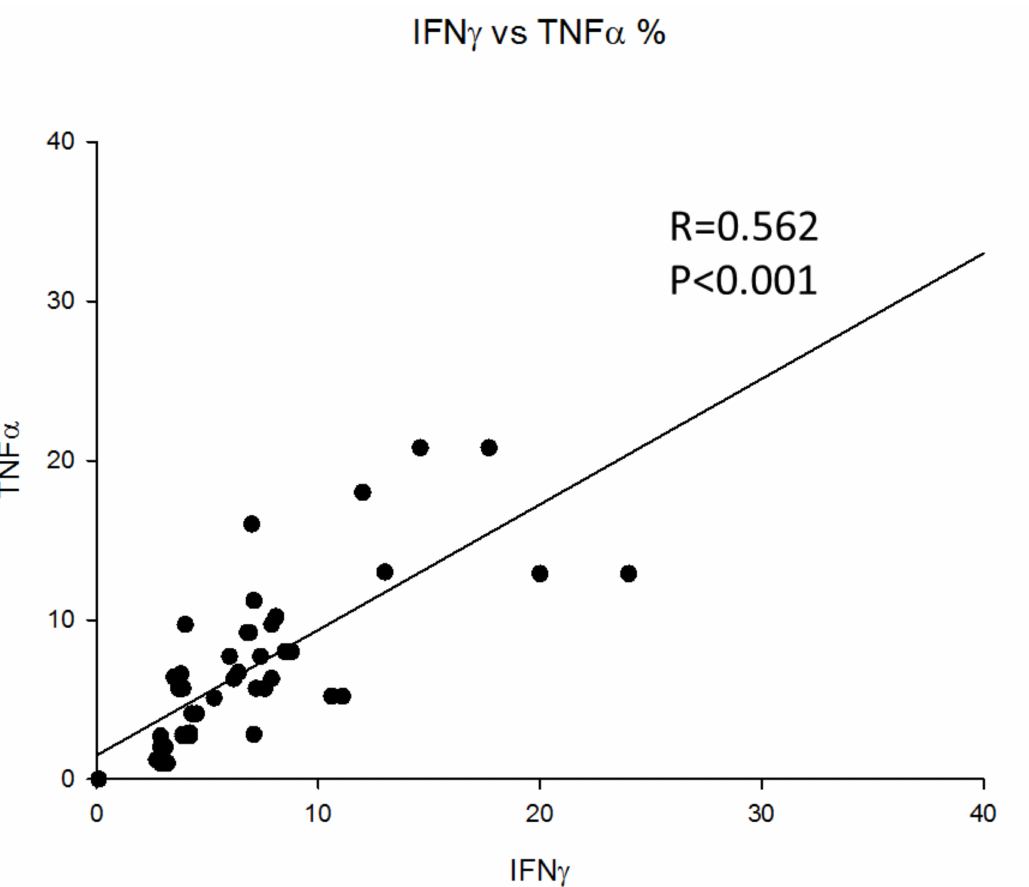
Figure 4. Correlations between the percentages of IFN γ and TNF-alpha expression by CD4 + T lymphocytes in MDD patients. Pearson correlation coefficient between percentages of expression of IFN γ and TNF-alpha was 0.562 ( p <